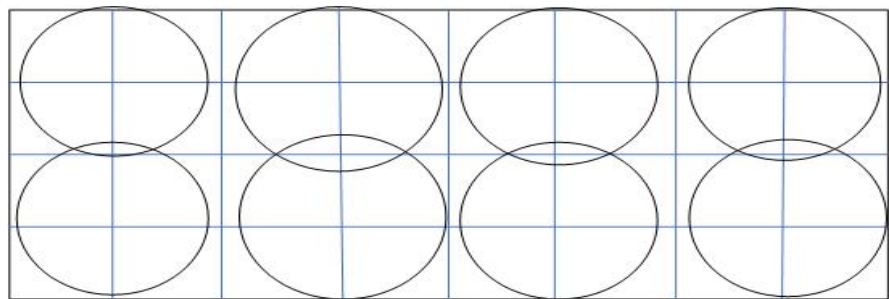
Sensors 2022 , 22 , x FOR PEER REVIEW Figure 5. Deterministic deployment. Figure 5. Deterministic deployment.